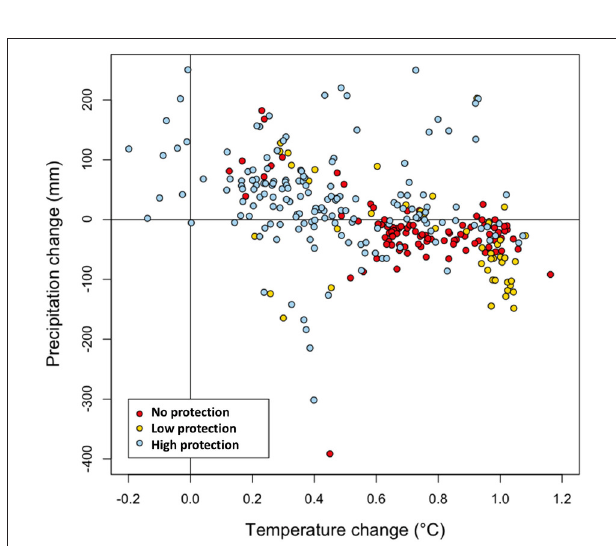
FIGURE 2 | Temperature and precipitation changes detected for 236 Mediterranean wetlands sites between 1990 and 2005. The colors a “high protection coverage” indicating that more than 50% of the total surface area of a site has a protection status (blue); a “low protection coverage” indicating that less or equal to 50% the total surface area of a site has a protection status (yellow); or “no protection coverage” (red). For more information on the method see the Supplementary material